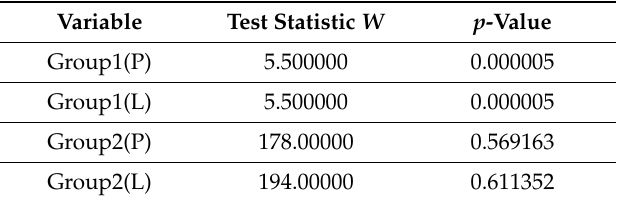
Table 6. Results of Wilcoxon signed-rank